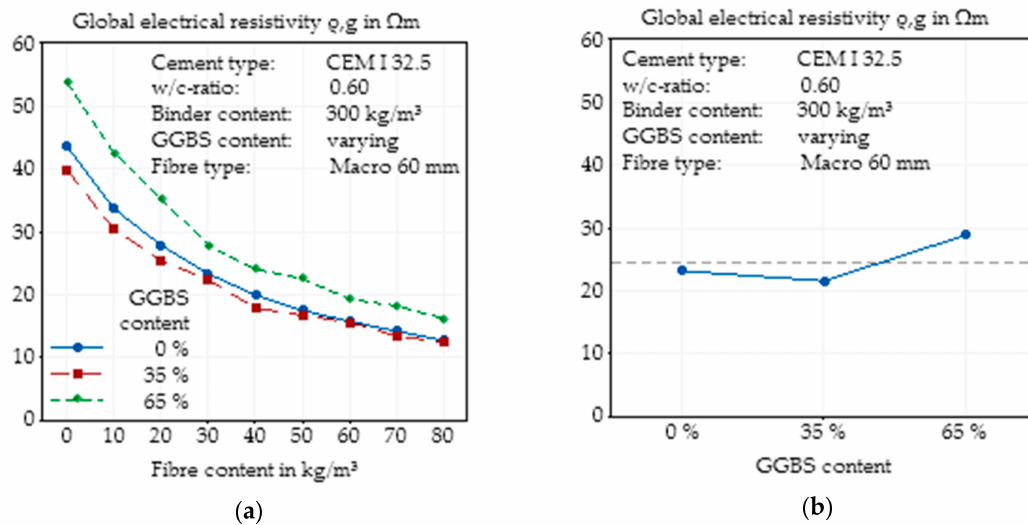
Figure 8. Effect of the addition of GGBS on the global electrical resistivity of SFRC as a function of fibre content ( a ) and main effect plot of the addition of GGBS on the global electrical resistivity of SFRC calculated by Minitab ( b